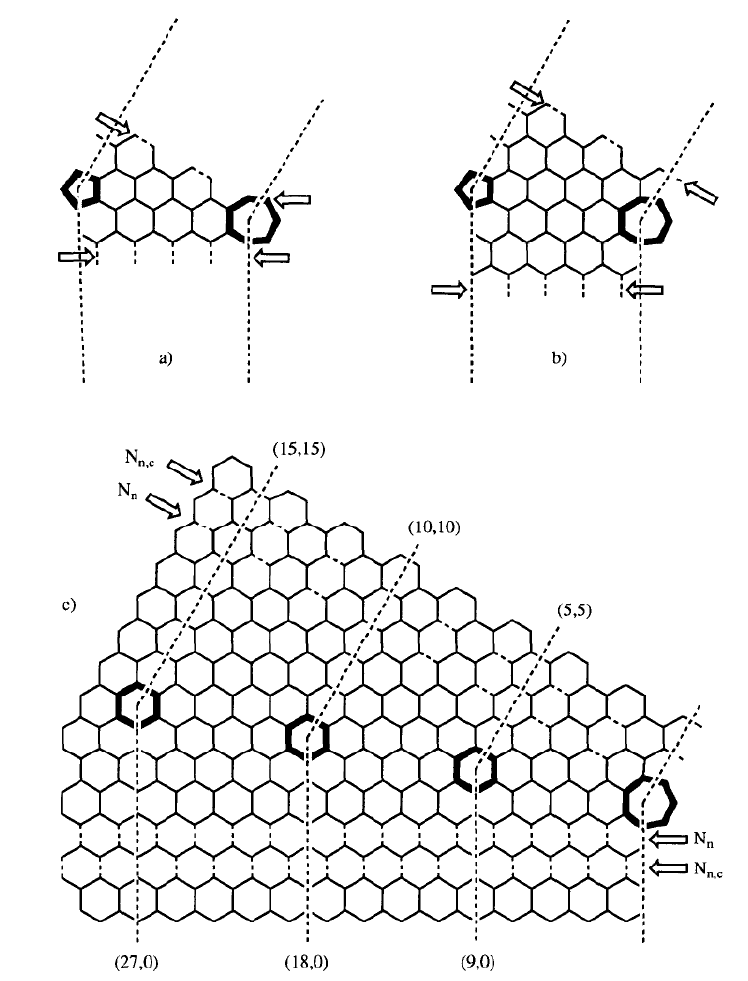
Figure 3. Planar presentation of the (9n,0)-(5n,5n) knees, having a 36° bend angle produced by a heptagon–pentagon pair on the equatorial plane. The arrows show the dotted line of bonds where the knee N or N is connected to the corresponding straight tubules: n n,c (a) knee N for n = 1; (b) stretched knee N for n = 1 and c = 38; (c) general knees N n n,c . Reproduced from [33] with N n,c